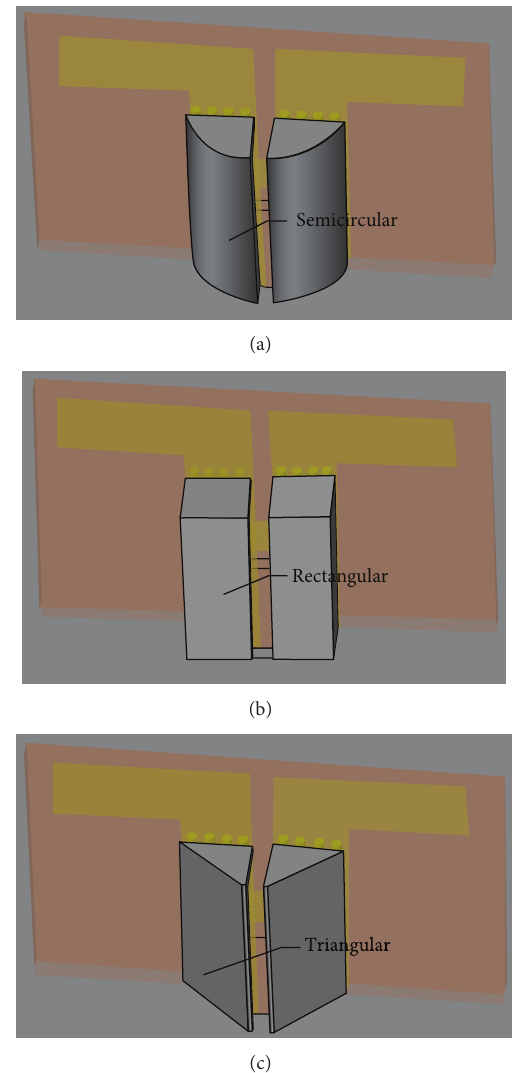
Figure 10: Three different kinds of slotted